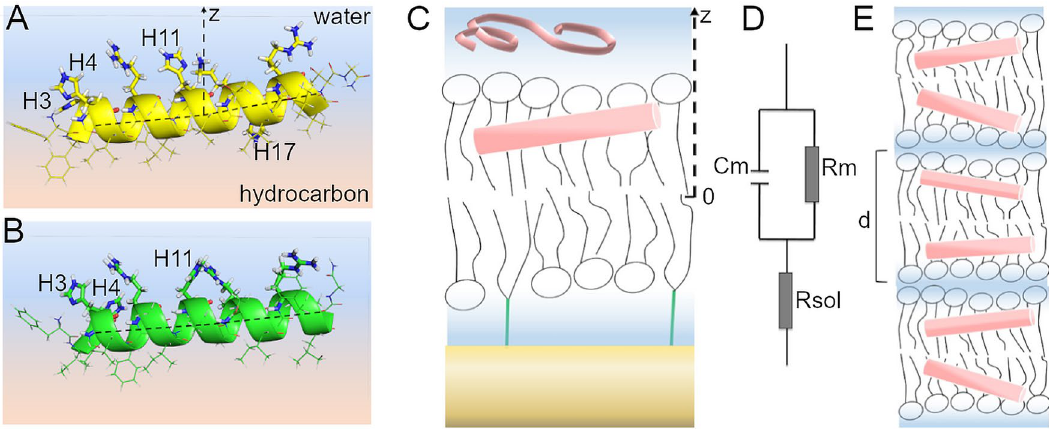
Figure 2. Techniques for investigating peptide-bilayer structural interactions. ( A ) High-resolution structure of piscidin P1: FFHHIFRGIVHVGKTIHRLVTG (MW 2571) and ( B ) Piscidin P3: FIHHIFRGIVHAGRSIGRFLTG (MW 2492). The shown structures were determined by solid state NMR in 4:1 POPC/cholesterol bilayers at P/L = 1:40 58 . The corresponding Protein Data Bank IDs are 6PF0 (P1) and 6PEZ (P3). The α-helices of the peptides lay at the bilayer-water interface, adopting orientations that are almost parallel to the bilayer surface. ( C ) Cartoon describing the tethered bilayer membrane used for Surface Plasmon Resonance (SPR), Electrical Impedance Spectroscopy (EIS) and neutron reflectometry (NR). The tethered molecules (green) create a 10 Å thick sub-membrane aqueous space. ( D ) The simplest electric circuit model to describe the surface-supported bilayer, characterized by the membrane capacitance (Cm), resistance (Rm), and solvent resistance (Rsol). ( E ) Oriented lipid multilayers with peptide incorporated as described in the Methods for the neutron diffraction (ND) experiments. The repeat spacing (d) denotes the dimension of the repeat unit (thickness of the bilayer with its hydration layer).